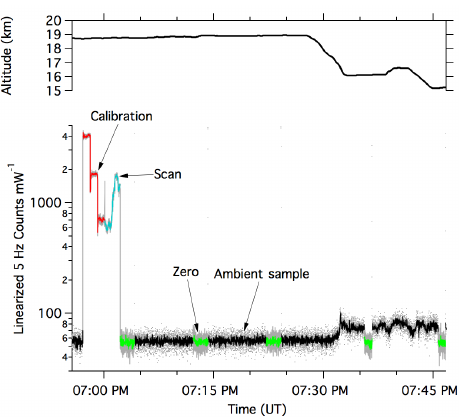
Figure 10. Data sample from flight on 27 October 2015. Top panel shows aircraft altitude, indicating a cruise in the lower stratosphere followed by descent into the upper troposphere. Bottom panel: gray dots show 5Hz data. Black, red, cyan and green show 1Hz averages of ambient sampling, calibration, laser wavelength scan and zero-air zeroing, respectively.